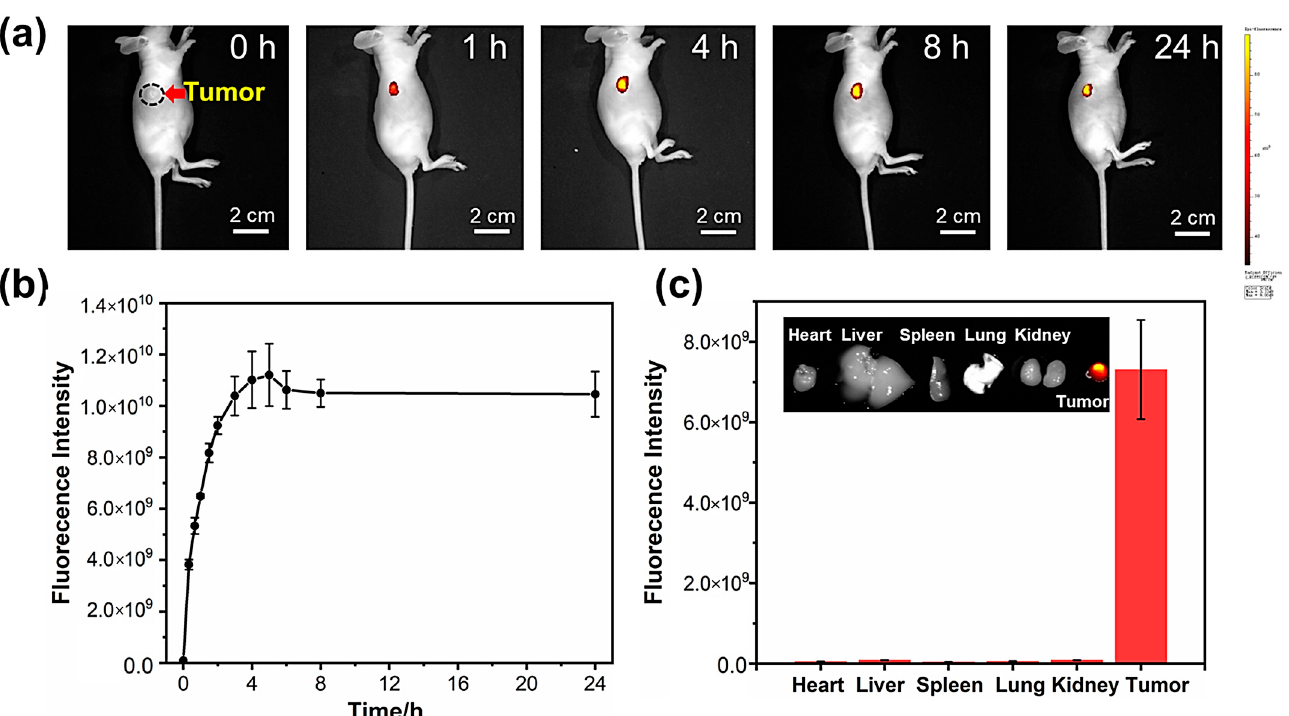
Figure 6. ( a ) In vivo imaging; ( b ) the quantitative fluorescence signal intensities of NMe 2 NBS at different time intervals in the solid tumor. ( c ) Ex vivo fluorescence imaging and fluorescence intensity of major organs and the tumor after intratumoral injection for 24 h.